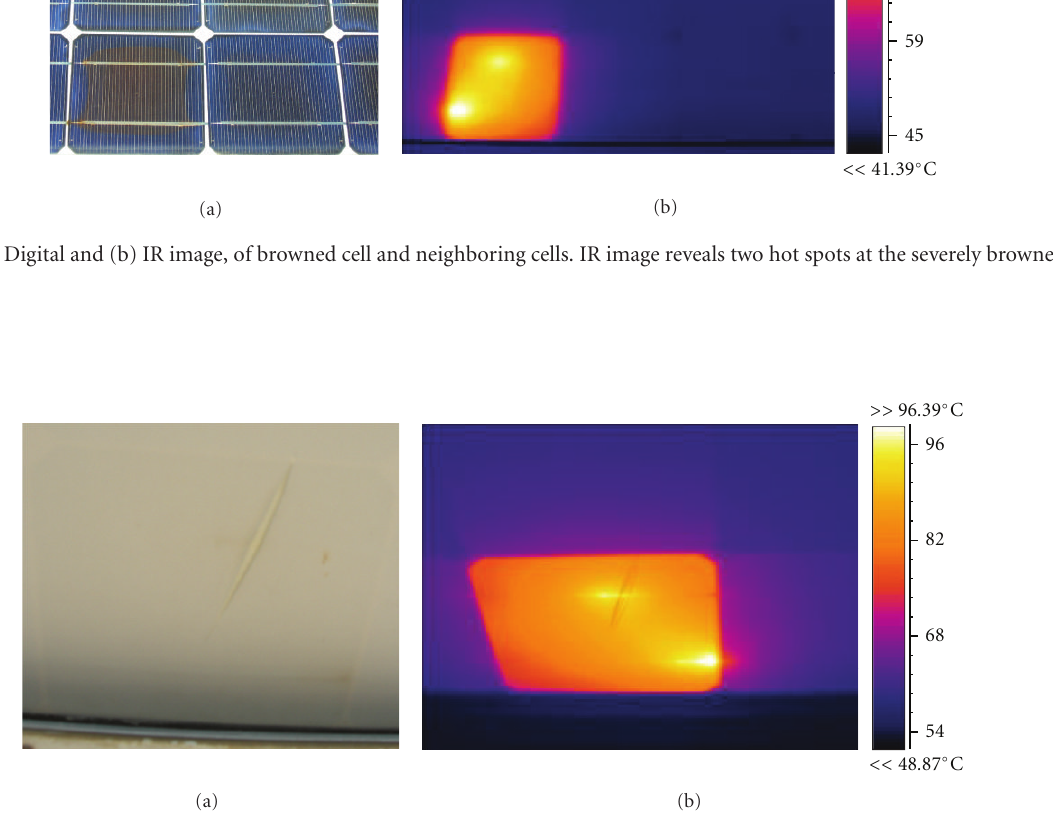
Figure 5: (a) Digital and (b) IR image, of the back of the severely browned cell of Figure 4. IR images reveals the two hot spots are located on the two bus bars. The tear of the tedlar sheet also appears in the IR